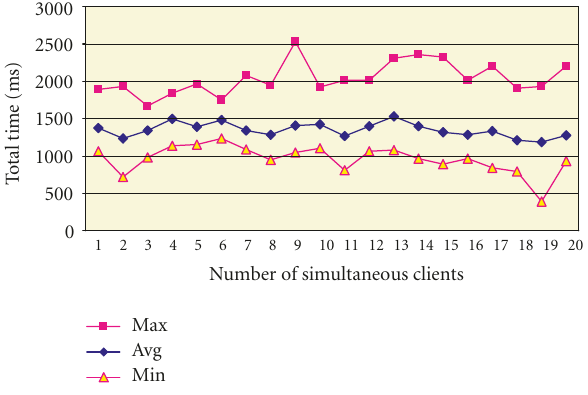
Figure 12: LCS total serve time versus number of